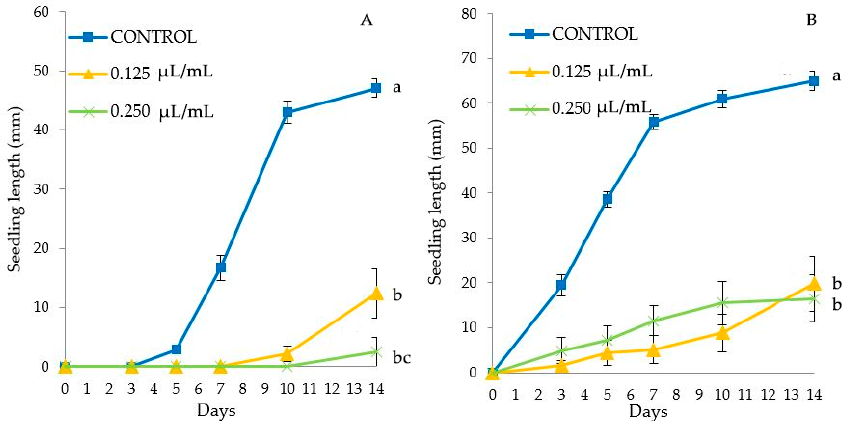
Figure 3. Phytotoxic effects of Thymbra capitata EO (TC3) on Solanum nigrum ( A ) and Setaria verticillata ( B ) seedling length (mm) (mean ± SE), measured for 14 days. Different letters at the end of the growth curves indicate significant differences among doses ( p < 0.05) using Fisher’s least significant difference (LSD) test.